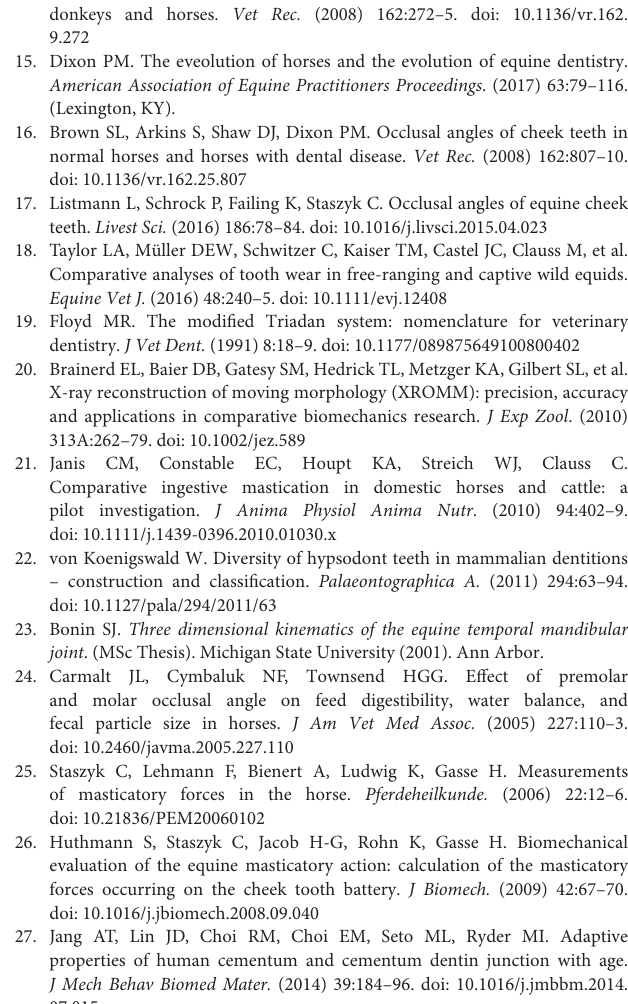
Supplementary Video 1 | Video of the simulation run 3 using the following simulation settings: normal simulation speed over cycle 1-3, cycle 4-10 with 4x time-lapse, cycle 11-94 with 32x time-lapse, cycle 95-105 with 4x time lapse, cycle 106-198 with 32x time lapse, cycle 198-200 without time-lapse: run 2.mp4. Supplementary Material 1 | Markdown file of the software program code: